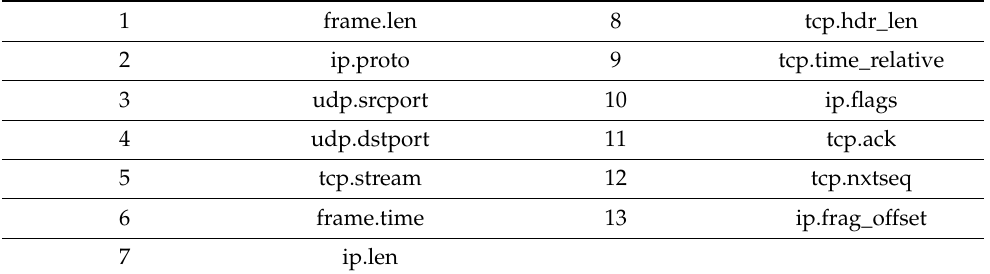
Table 2. Features finalized after selection